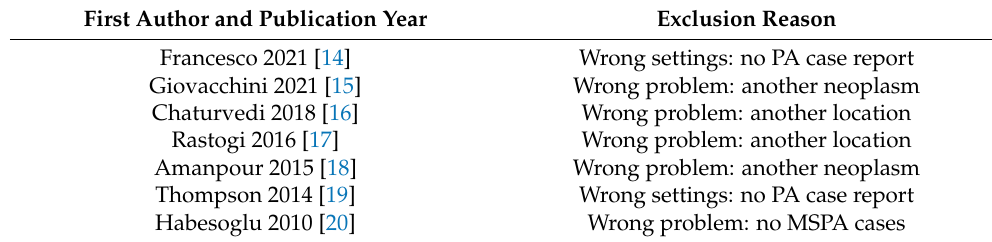
Table 5. Records excluded at the eligibility stage.